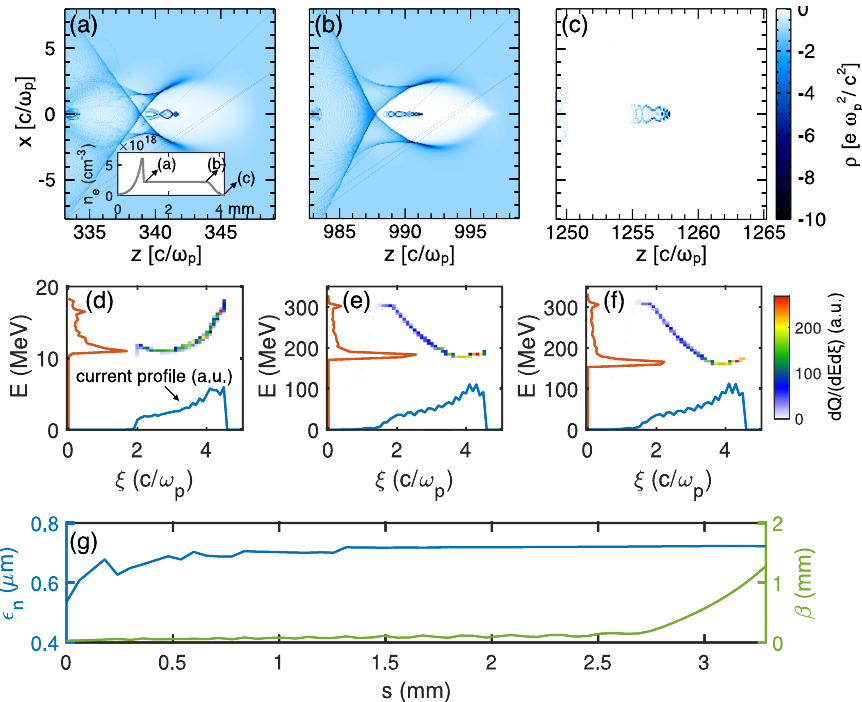
FIG. 8. Full-scale simulation including the injection, acceleration, and matching sections. (a) – (c) show the plasma density plots at positions marked in the inset in (a), which correspond to the position of injection, the end of acceleration, and the matching section. (d) – (f) show the longitudinal phase spaces of the injected bunch. The blue lines are the current profile in arbitrary units, and the red lines show the energy spectrum of the bunch. The blue (green) line in (g) shows the evolution of the average slice emittance (beta function) as a function of the acceleration